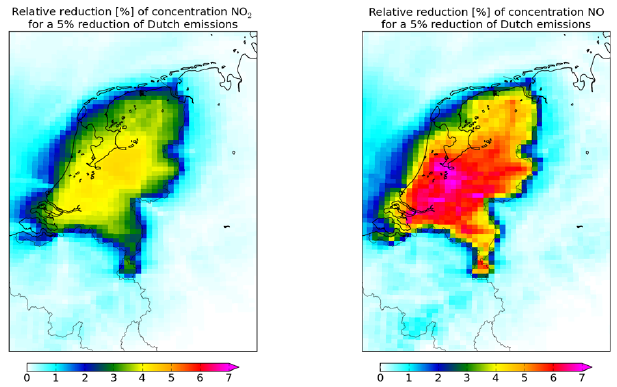
Fig. 6. Relative contribution of the 5% labelled Dutch emissions to the total concentration of NO 2 (left) and NO (right). These simula- tions are valid for the month July of